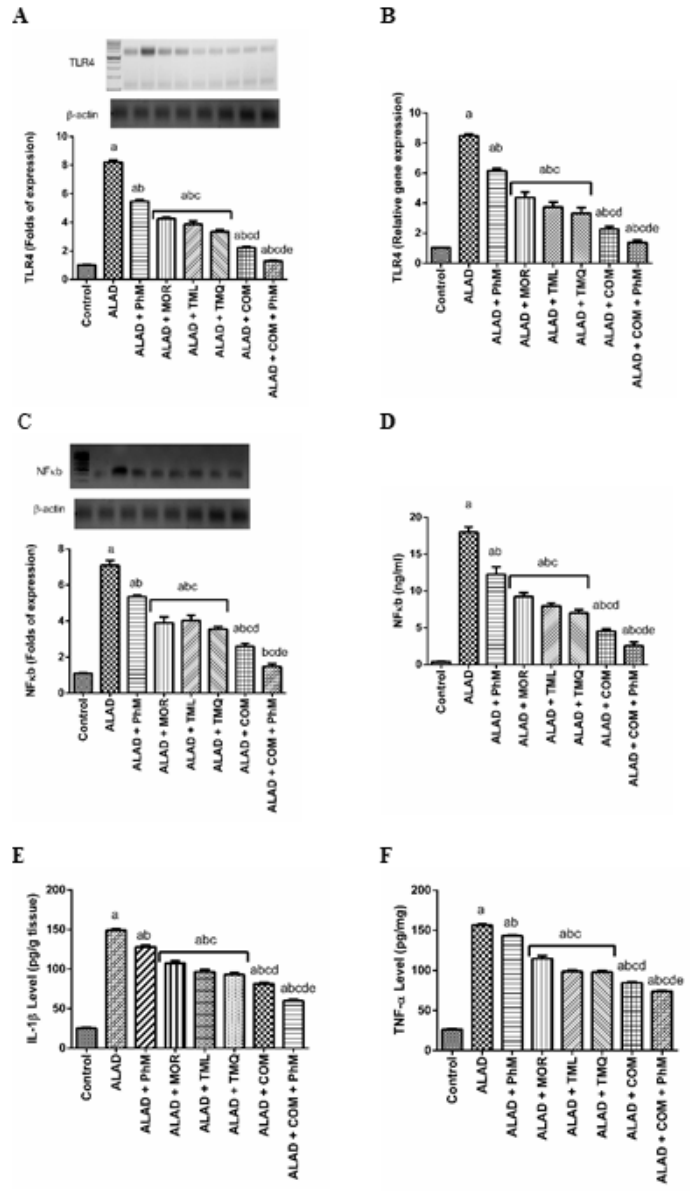
Figure 4. The effect of phytochemicals combination, MOR, TML, and TMQ, with PhM on TLR4 sig- naling and inflammatory cascade in AD. ( A ) Protein expression of TLR4, ( B ) Relative gene expression of TLR4, ( C ) Protein expression of NF- κ b, ( D ) Relative gene expression of NF- κ b, ( E ) Protein levels of IL- 1β, ( F ) Protein levels of TNF- α. The data are presented as means ± SD ( n = 7). Significance (a): relative to the control group. Significance (b): relative to the ALAD group. Significance (c): relative to ALAD + PhM group. Significance (d): relative to either ALAD + MOR, ALAD + TML, or ALAD + TMQ group. Significance (e): relative to ALAD + COM group Significance: p < 0.05. The data of the effect of MOR, TML and TMQ on the control are not shown as they were not significant.